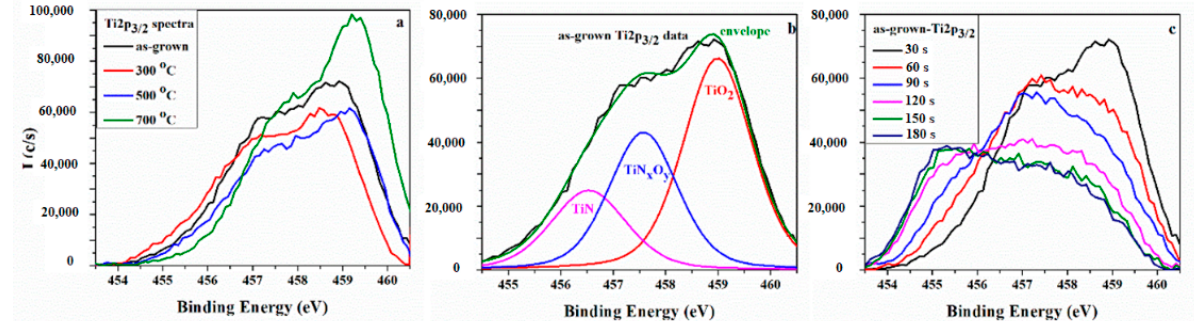
Figure 6. ( a–c ): ( a ) High resolution XPS spectra of Ti2p 3/2 of as-grown and annealed TiN films, taken after 30 s etching. ( b ) Peak fitting of high resolution XPS spectrum of Ti2p 3/2 of as-grown TiN film. ( c ) High resolution XPS spectra of Ti2p 3/2 of as-grown TiN film, taken at different etching level. A plot of N1s/Ti2p 3/2 peak atomic ratio as a function of etching time is shown